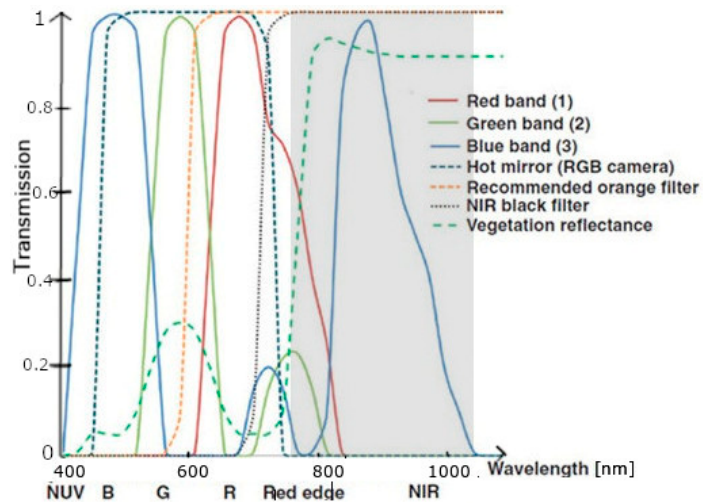
Figure 4. Sony NEX-5T spectral response functions (based on [53]).